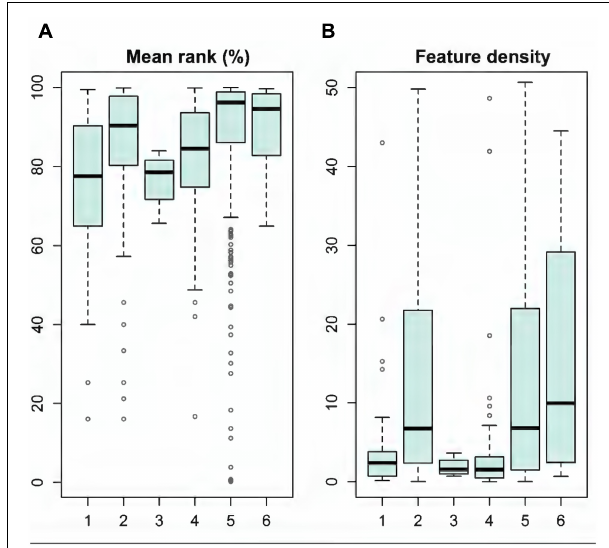
FIGURE 7 | Evaluation of the existing MPAs based on data from Landscape Mask (LSM) analysis (see details in section “Analysis Variants and Post-processing”). MPA categories: (1) HELCOM MPAs, (2) Natura 2000 sites, (3) National parks, (4) Nature reserves, (5) Private MPAs, and (6) Ramsar sites. (A) Shows the mean rank (%) of MPAs and (B) feature density of